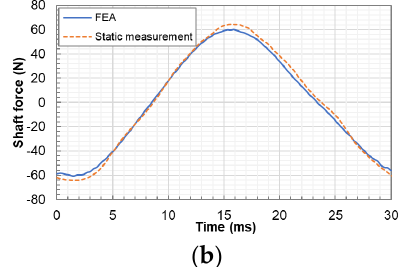
Figure 8. Transient motor force in one cycle from the FEA model and 3-D map interpolation: ( a ) a stroke of 9 mm ( b ) a stroke of 11 mm for the moving magnet linear motor.